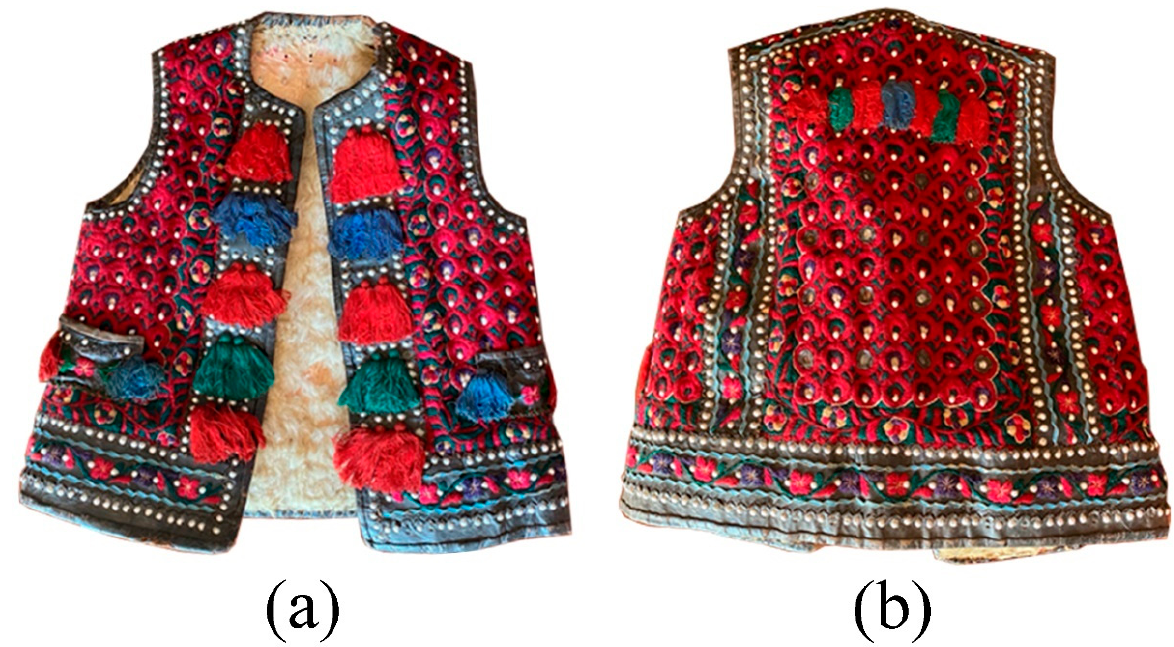
Figure 1. Traditional Romanian men’s coat; ( a )—front view; ( b )—back view. The coat was made of hemp thread (also called ‘ pânz ă de tort ’ in Romanian). The coat’s lining consisted of sewn tanned lambskin, of curly wool. On all its edges and at the seams, an intensely dark-hued strip (‘ cipc ă ’) or hem of red leather was applied, conveying a sense of perfect regularity and symmetry. On the inside, there was a large pocket on the left side, facilitating access by the right hand. The coat was decorated by hand-sewing (similar to embroidery), with coloured thread, and by applying decorative elements made of tanned leather, over the whole bridge of the coat, consisting of the tree of life, rose flowers called ‘ ruji ’, stitched flowers encircling mirrors and pseudo zig-zag patterning. In the